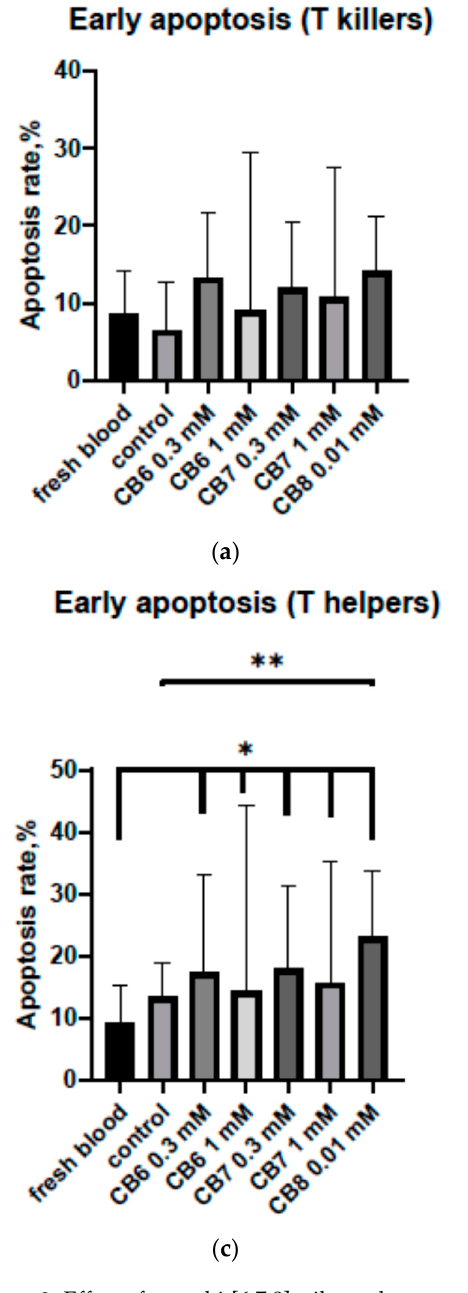
Figure 3. Effect of cucurbit[6,7,8]urils on the apoptosis of PBMCs: ( a ) Effect of cucurbit[6,7,8]urils on the early apoptosis of T killers; ( b ) effect of cucurbit[6,7,8]urils on the late apoptosis and necrosis of T killers; ( c ) effect of cucurbit[6,7,8]urils on the early apoptosis of T helpers; ( d ) effect of cucurbit[6,7,8]urils on the late apoptosis and necrosis of T helpers. * Indicates a significant difference ( p < 0.05) vs. the apoptosis in fresh blood; ** indicates a significant difference ( p < 0.05) vs. the control. Data are presented as the median with the interquartile range (n = 11).